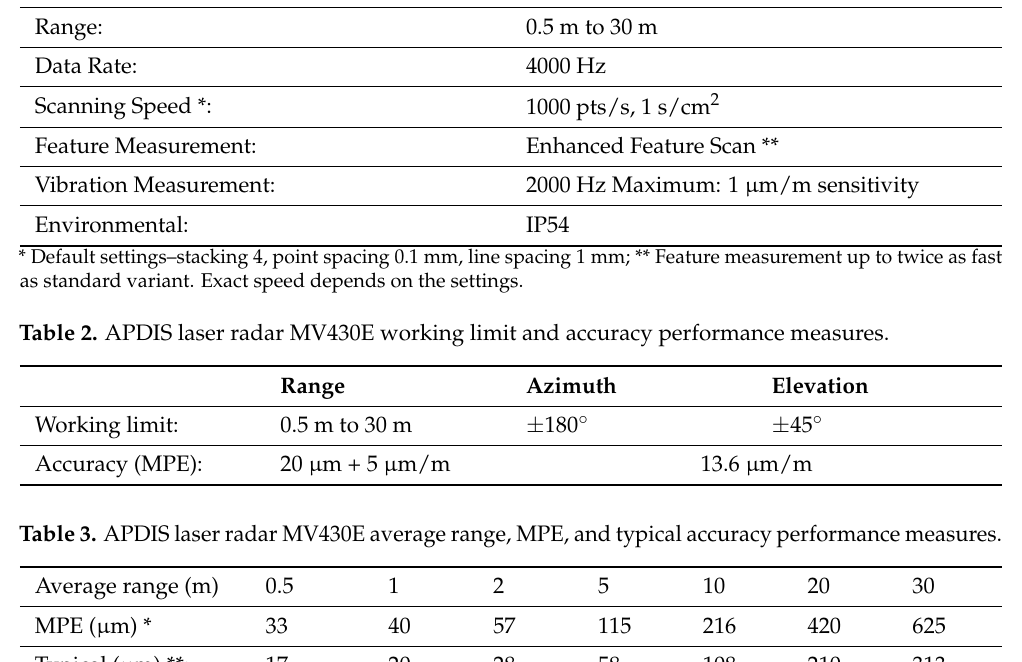
Table 1. APDIS laser radar MV430E product specification and performance measures.